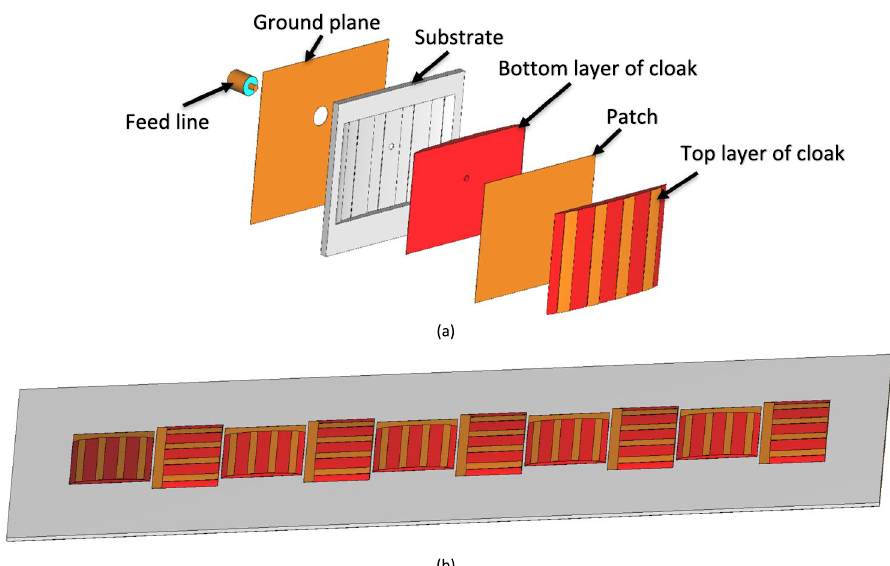
Figure 5. ( a ) Different layers of the mantle cloaked patch antenna, ( b ) 3D view of the two co-frequency interleaved cloaked